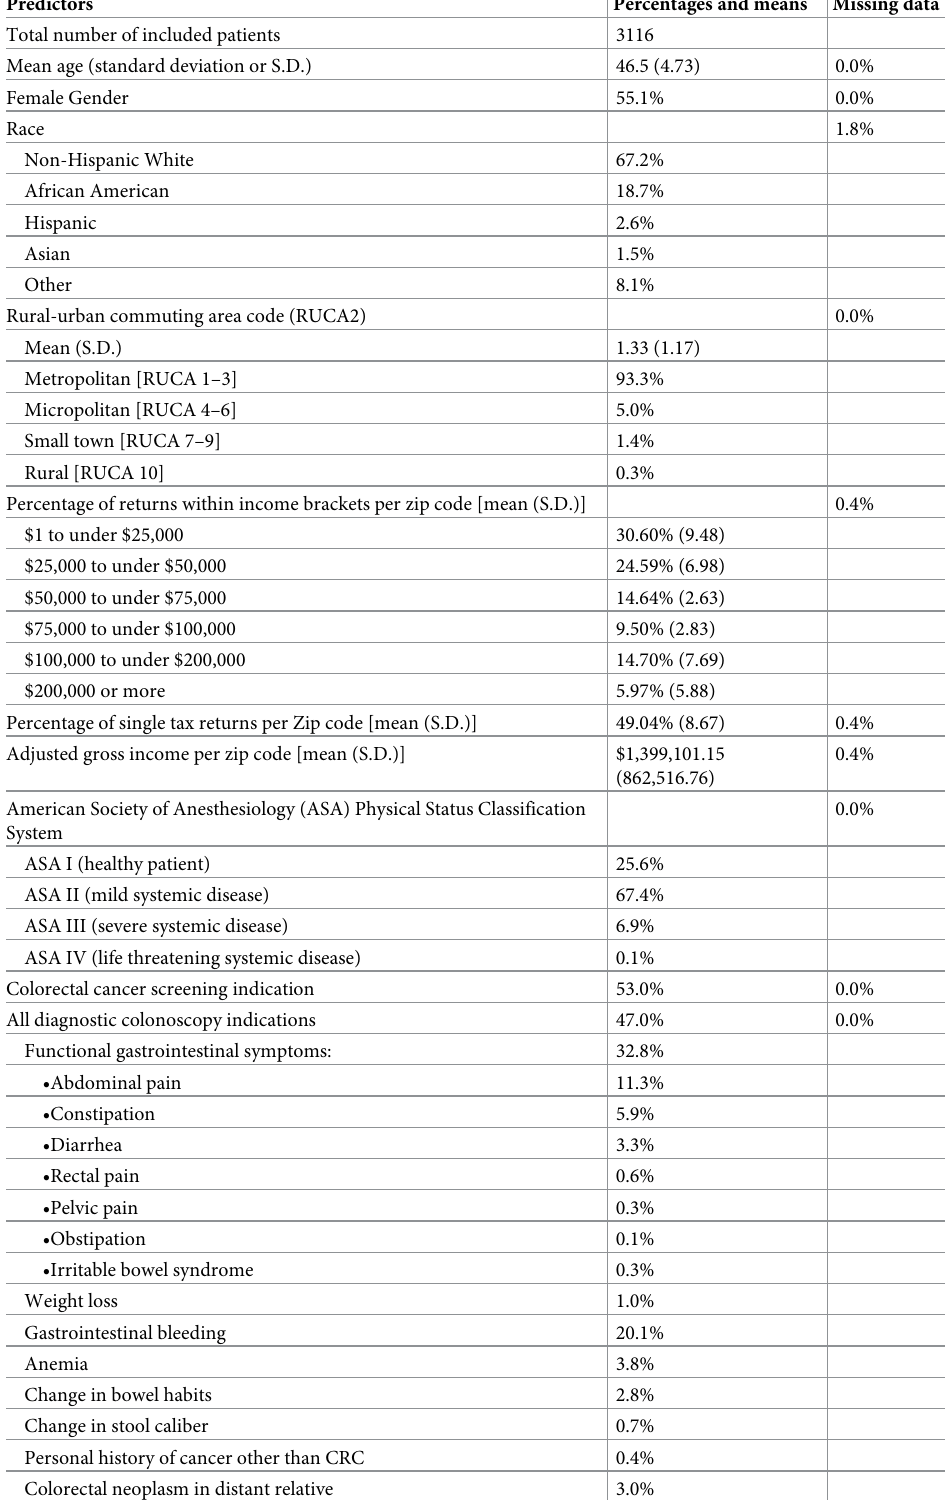
Table 1. Included predictors and baseline